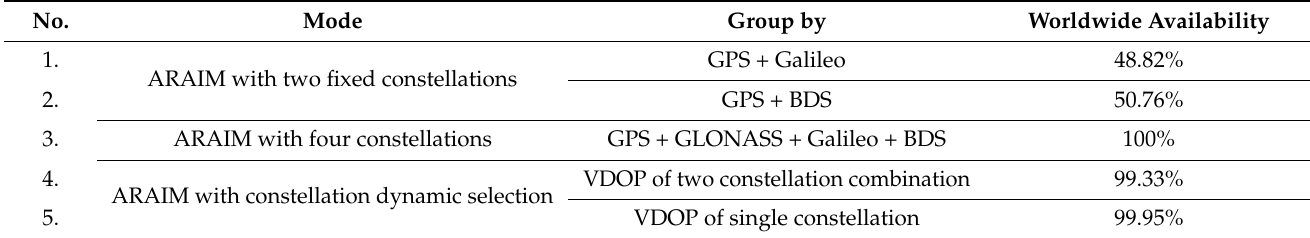
Table 4. Worldwide availability of ARAIM in depleted GPS